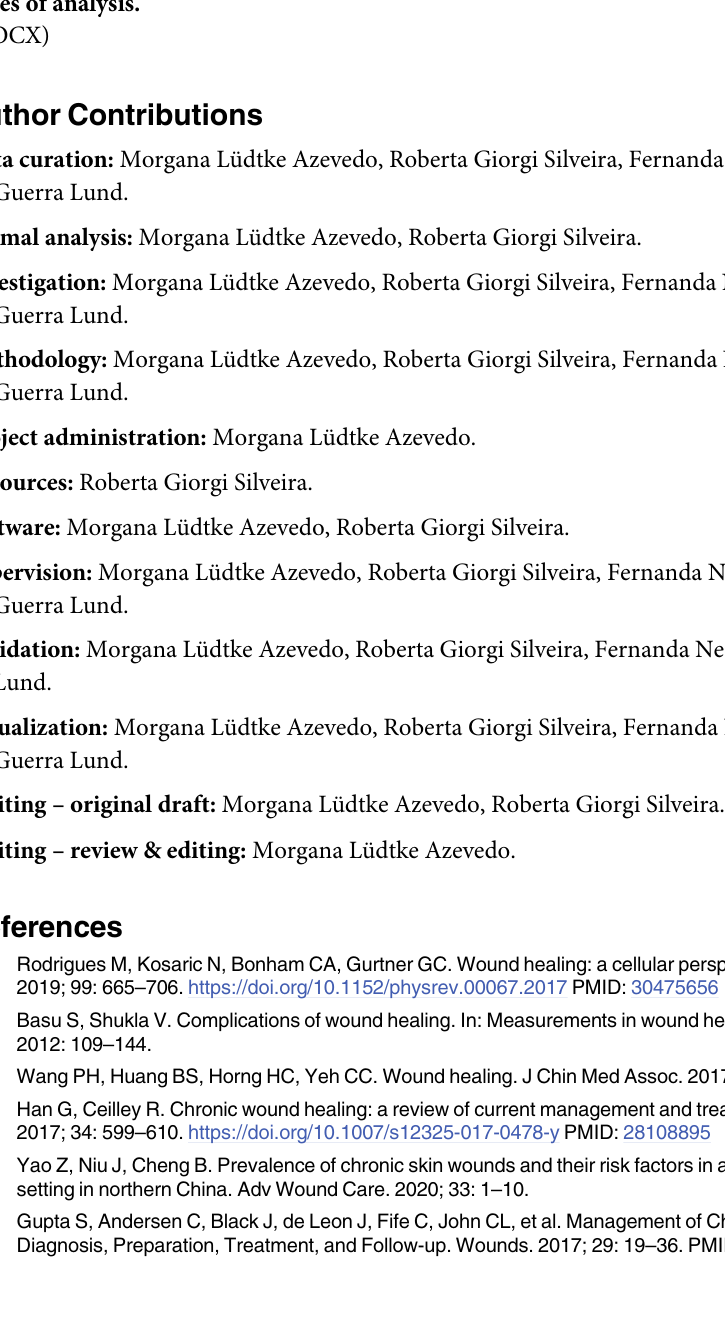
S1 Table. Correlation of results regarding the expression pattern of miRNAs at different times of